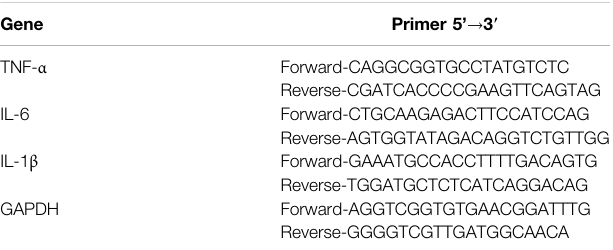
Table 3 . Last, gene expression was calculated using the 2 ΔΔ Ct method.